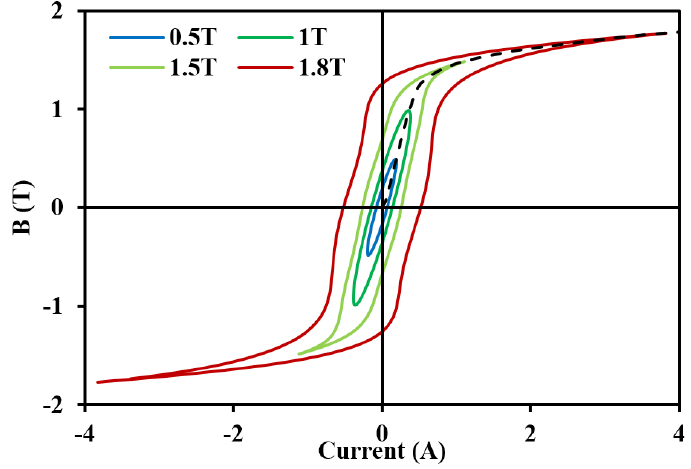
Figure 5. B - I curves with sinusoidal excitations at 50 Hz.